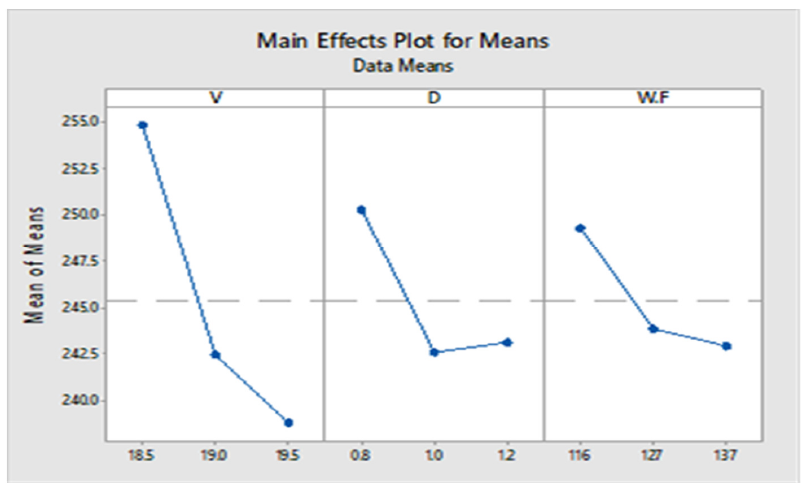
Fig. 10. The mean for the microhardness